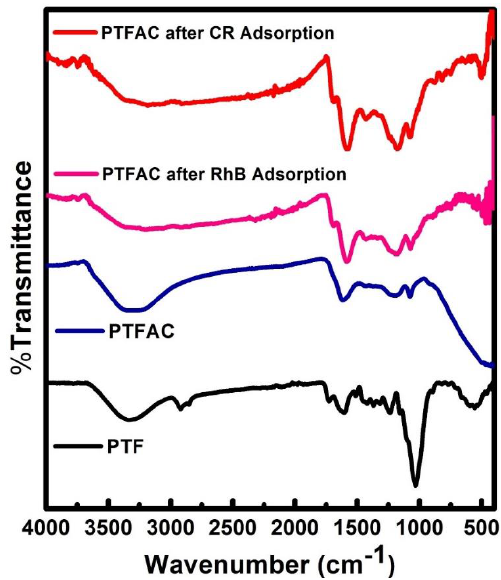
Figure 5. The comparison of Fourier transform infrared spectroscopy (FTIR) spectra of palm tree fiber (PTF) before and after the activation and after adsorption of Rhodamine B (RhB) and Congo red (CR) dyes by PTFAC.